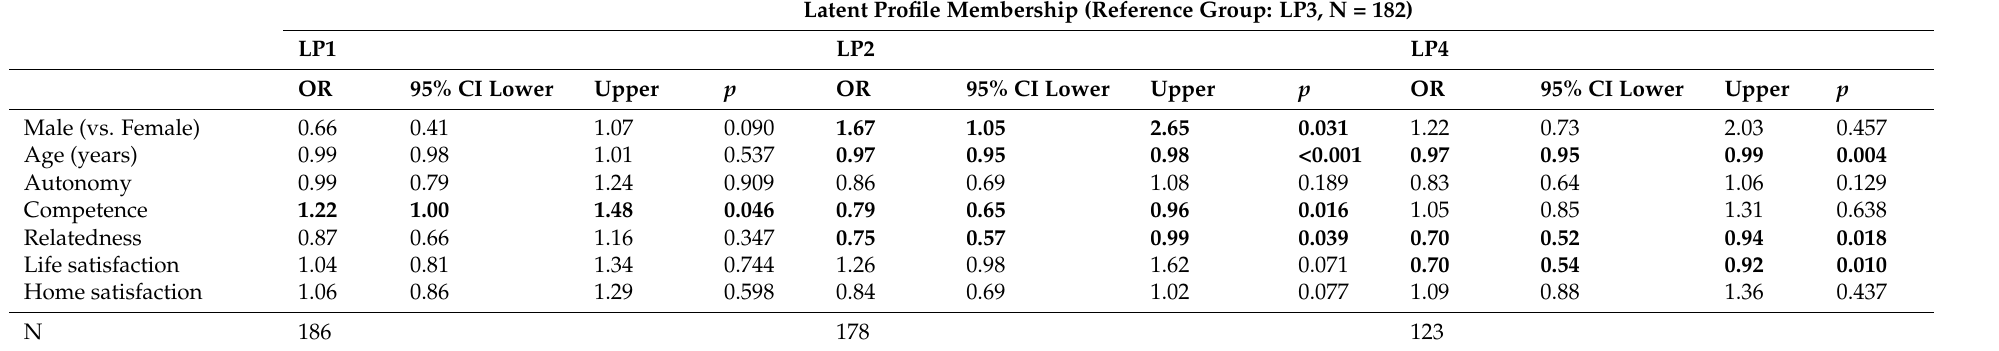
Table 5. Multiple logistic regression of the latent profile group